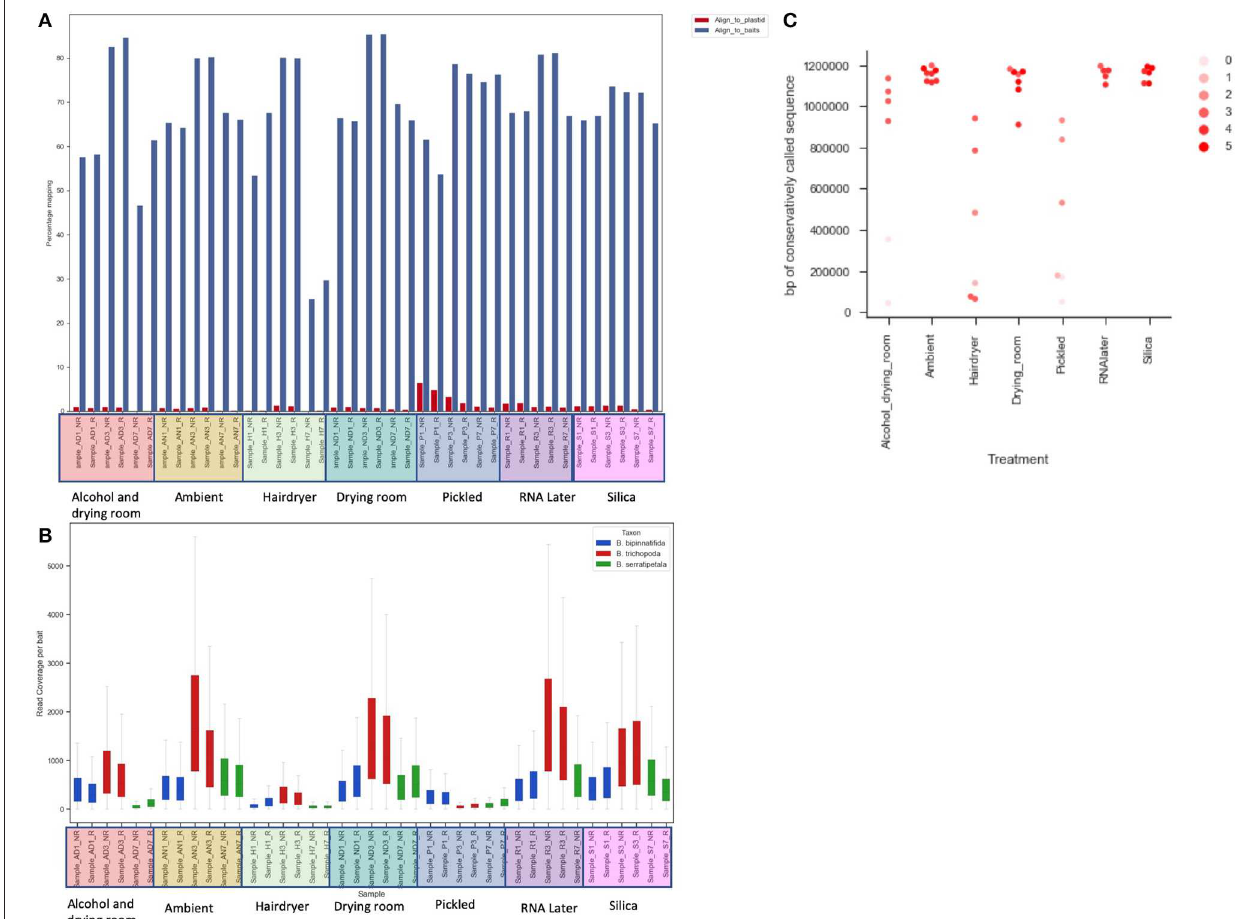
FIGURE 4 | The effect of treatment on recovery of bait sequence, coverage of baits and length of consensus sequence called. (A) Effect of treatment on percentage of reads mapping to baits (blue) and to plastid sequence (red) using BWA. (B) Read coverage per bait by treatment (x-axis) and by species (color of bar). (C) Length of sequence retrieved from each sample using conservative BWA mapping by treatment (x-axis) and library quality (arbitrary scale—see text; shade of marker).